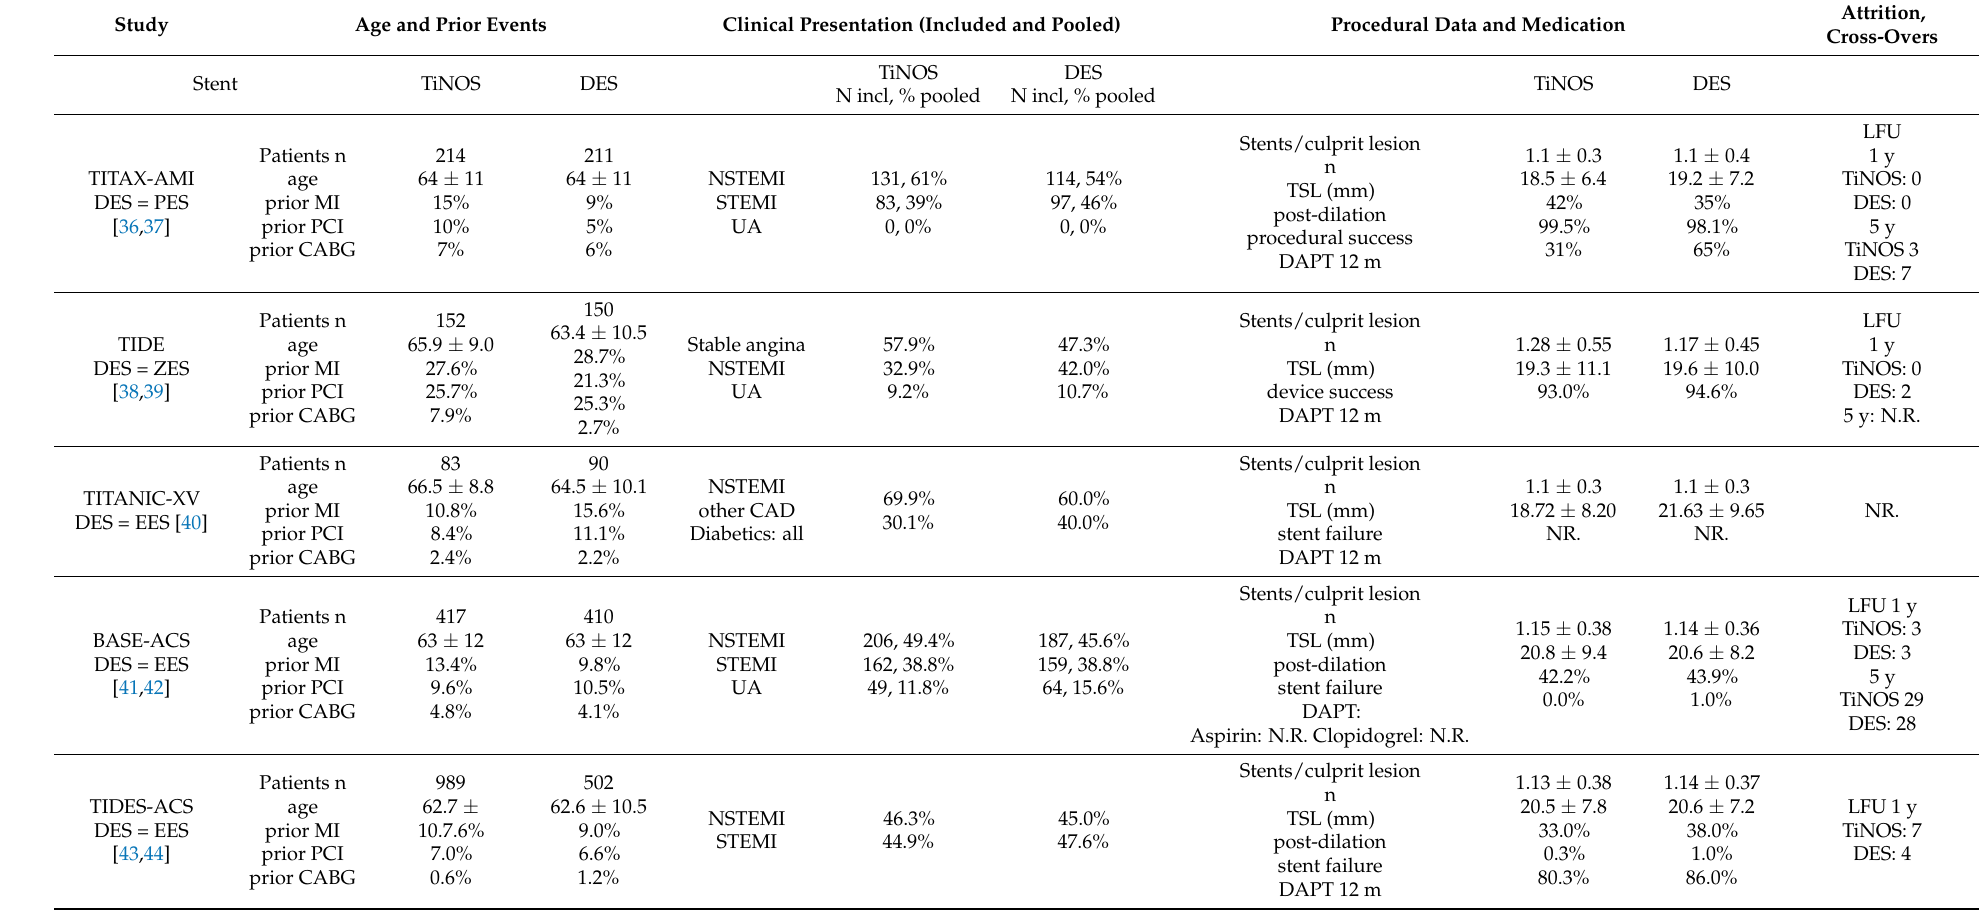
Table 1. Eligible studies’ baseline